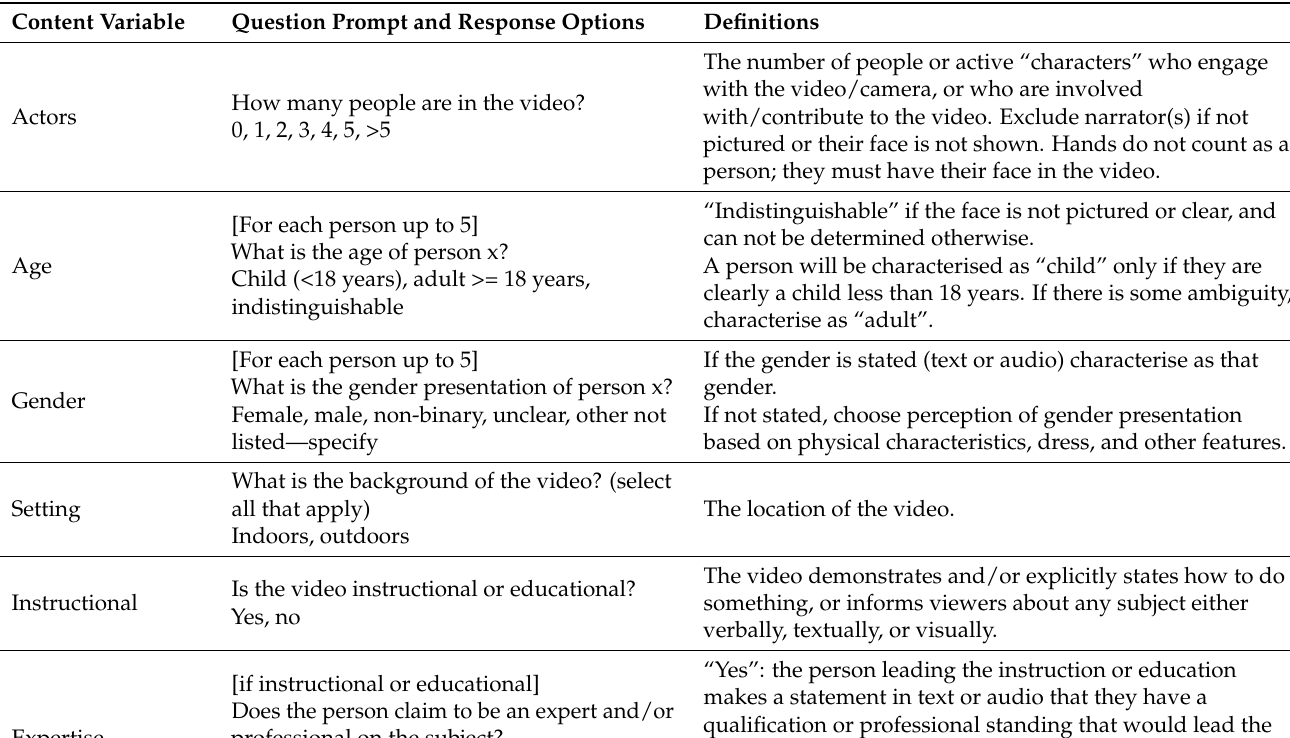
Table 2. Generic codebook variables, survey questions, and